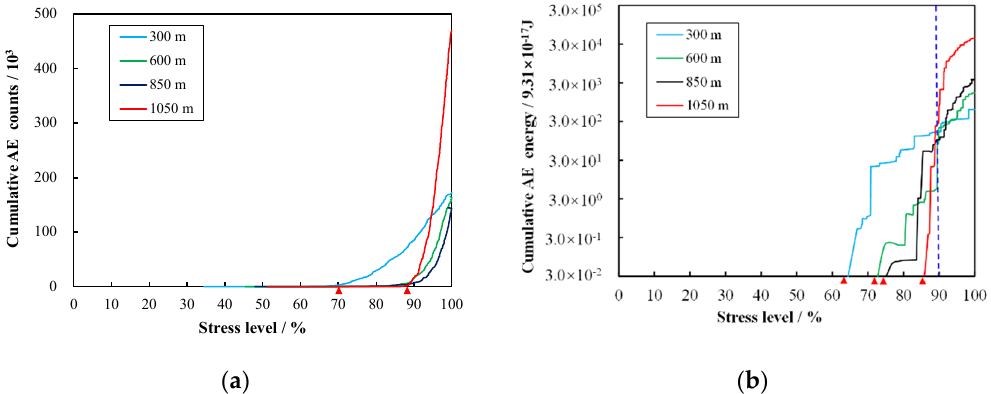
Figure 5. Variation in the cumulative AE counts and cumulative AE energy of coal samples at different depths with respect to the axial stress level: ( a ) cumulative AE counts at different depths; ( b ) cumulative AE energy at different depths.